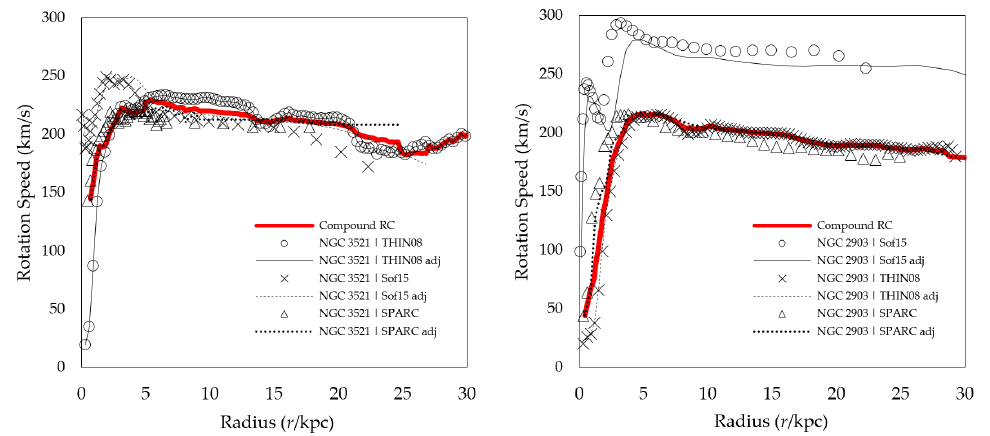
Figure A4. On both charts: X-axis shows the distance from the galactic center in kpc; Y-axis rotational velocity in km / s; Circles, triangles, and crosses —original datapoints from respective sources; solid and dashed black lines —RCs adjusted to adopted inclination and distance; and red curve —resulting compound